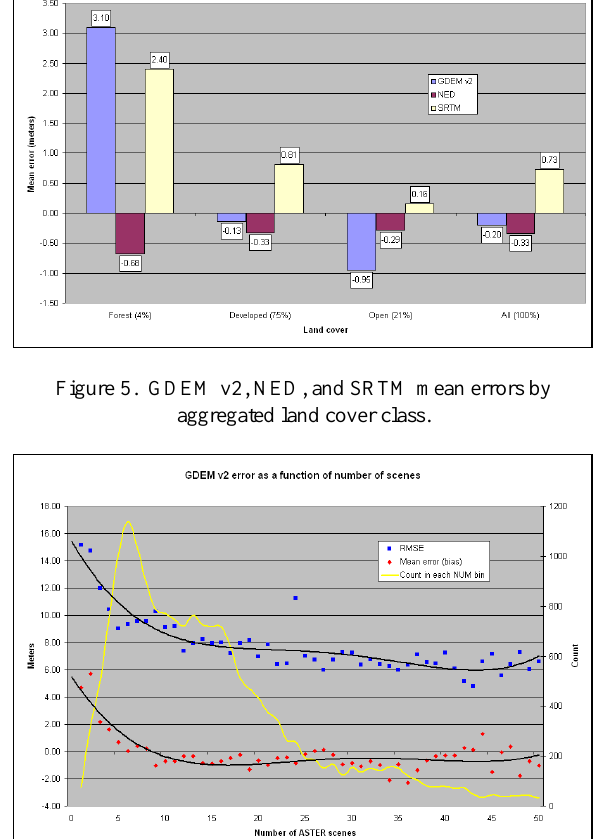
Figure 6. GDEM v2 mean error and RMSE vs. number of scenes used for elevation calculation.